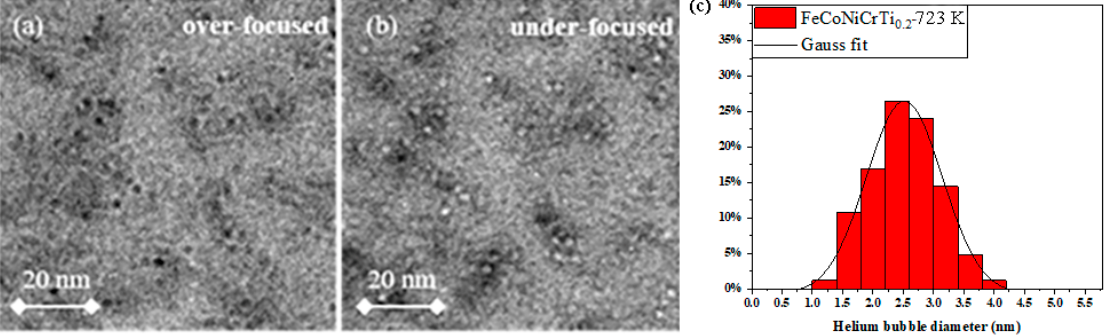
Figure 2. Distribution of helium bubbles and Gaussian fitting in the FeCoNiCrTi 0.2 alloys after pre-irradiation at 723 K. ( a ) over-focused; ( b ) under-focused; ( c ) He bubbles distribution.